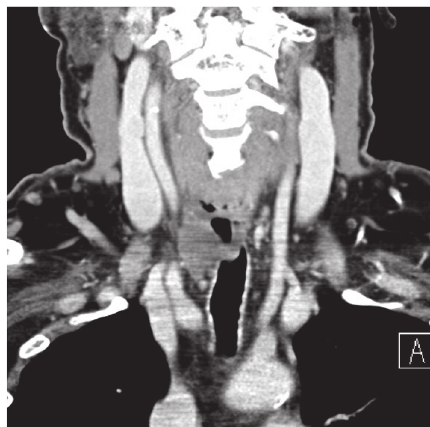
Figure 8: CT scan of the neck after 25 doses of pembrolizumab (coronal